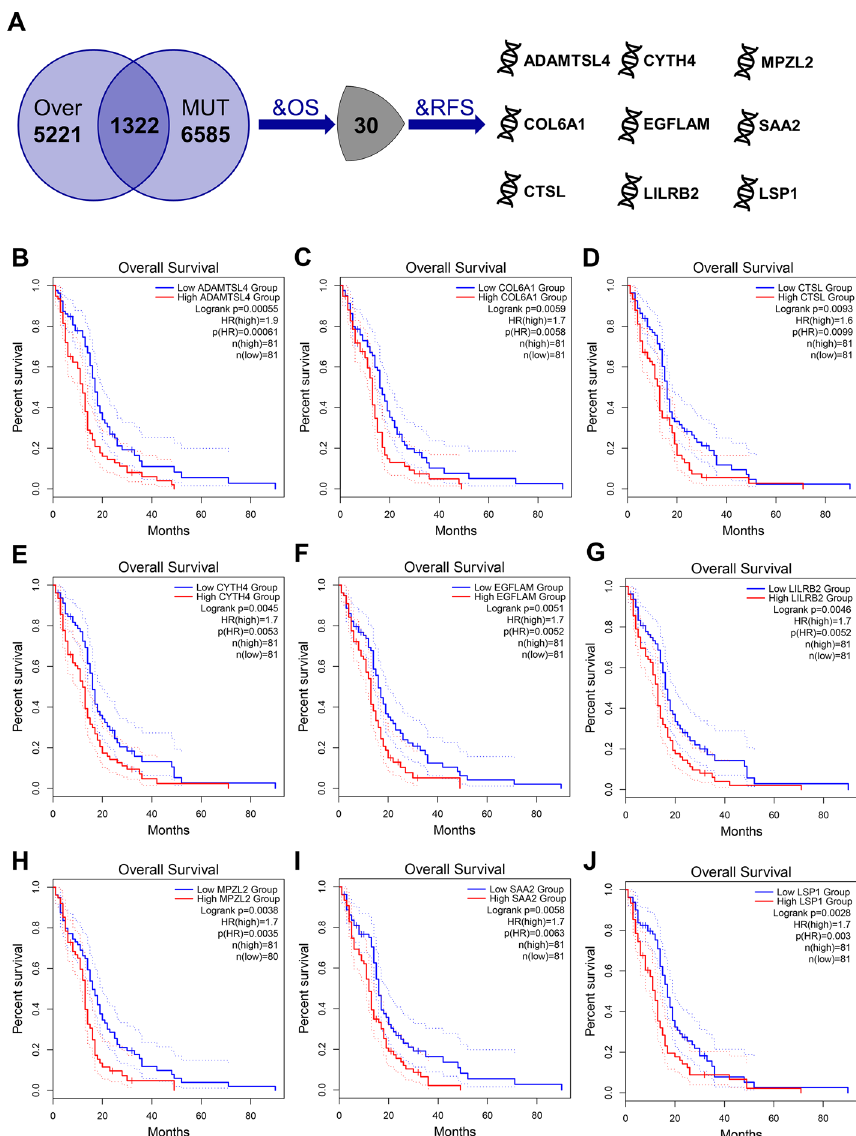
Fig. 2 Identification of tumor antigens associated with GBM prognosis. a Potential tumor antigens (total 1332) with both overexpression and mutation, and tumor antigens significantly associated with OS and RFS (total 9 candidates). Kaplan–Meier curves comparing OS for groups with different expression of ADAMTSL4 ( b ), COL6A1 ( c ), CTSL ( d ), CYTH4 ( e ), EGFLAM ( f ), LILRB2 ( g ), MPZL2 ( h ), SAA2 ( i ), and LSP1 ( j ) in GBM. Red lines represented high gene expression, blue represented low gene